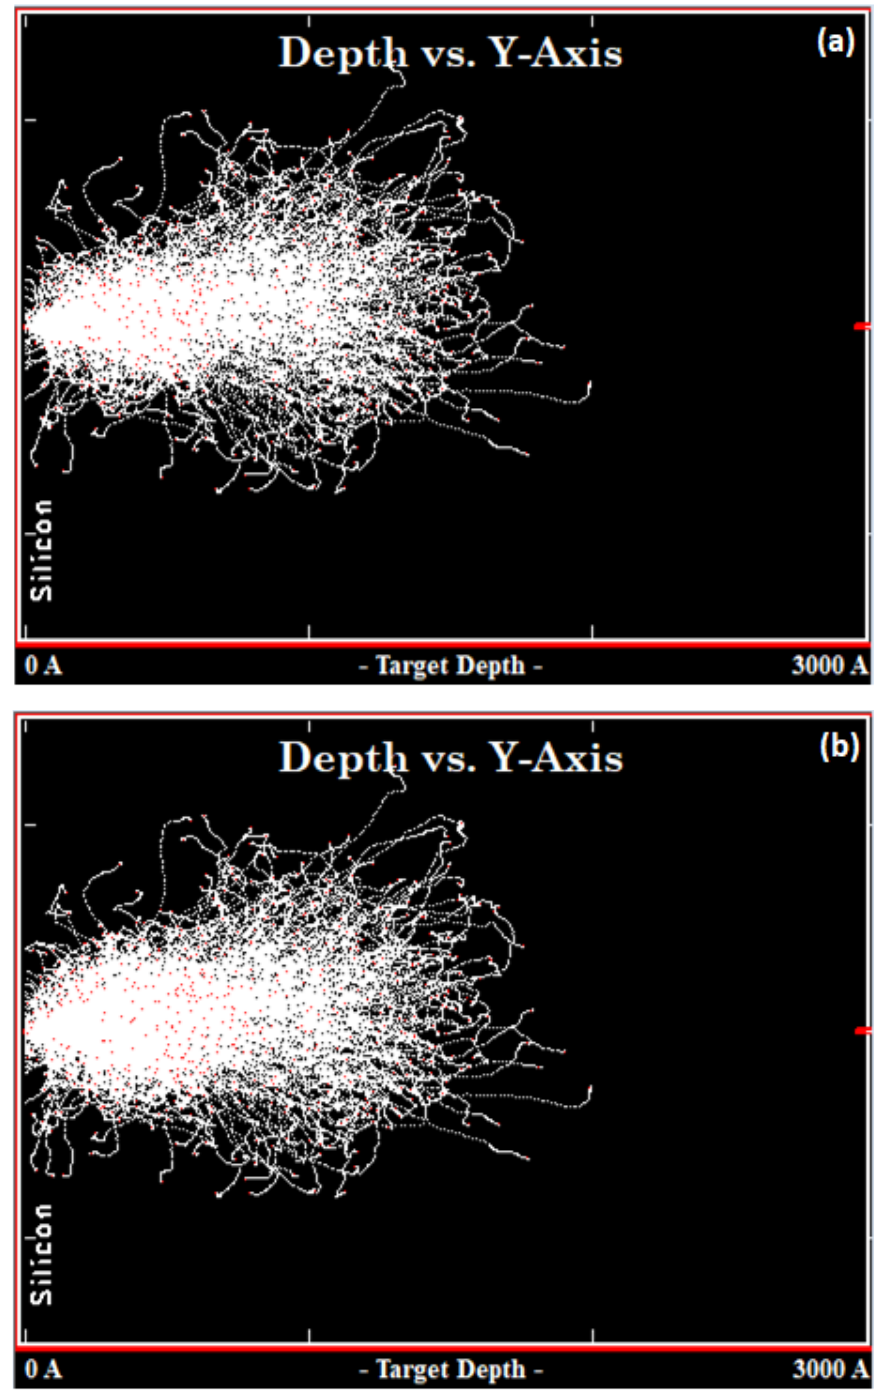
Figure 10. SRIM result for samples ( a ) C and ( b ) G. The ions’ distribution in the silicon sample can be